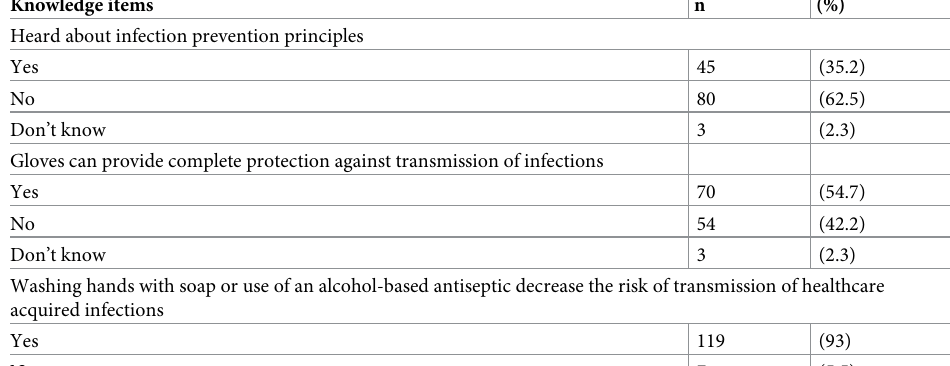
Table 2. Community healthcare provider’s knowledge regarding infection prevention. Knowledge